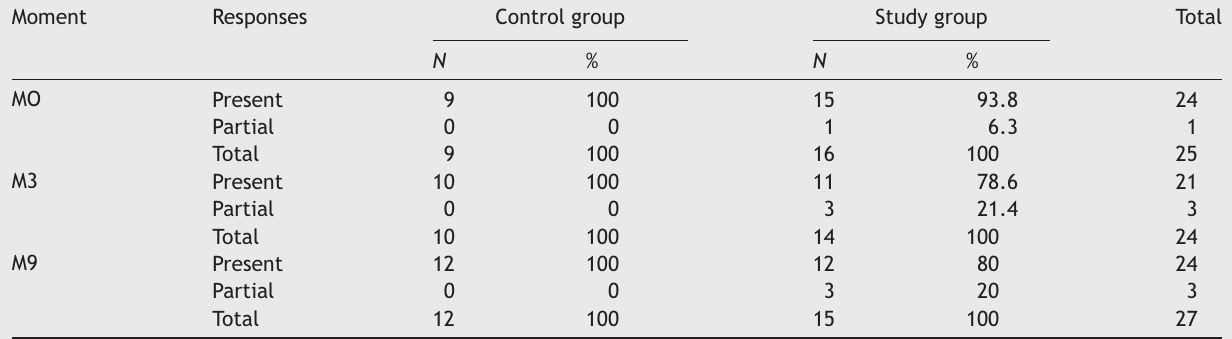
Table 1 Comparison between the distribution of the occurrence of present and partial responses at each moment for the control and study groups.